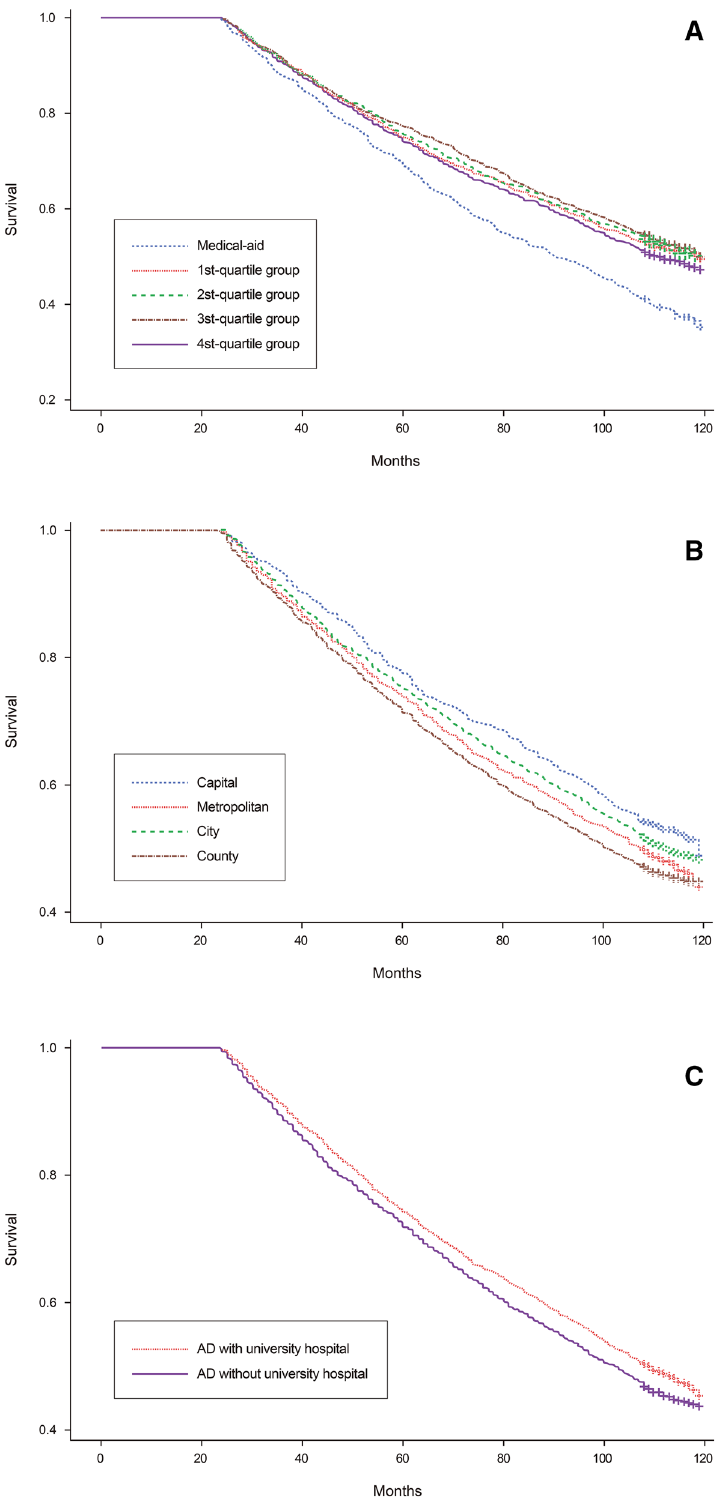
Figure 2. Kaplan–Meier survival curves according to: ( A ) each national health insurance premium (NHIP) level, ( B ) each residential area level, and ( C ) the presence or otherwise of a university hospital(s). The higher the NHIP level, the higher the survival rate ( P < 0.001). The survival rate in the capital was the highest, and the county level showed the lowest survival rate ( P < 0.001). Administrative districts with a university hospital(s) showed a higher survival rate compared to those without ( P =